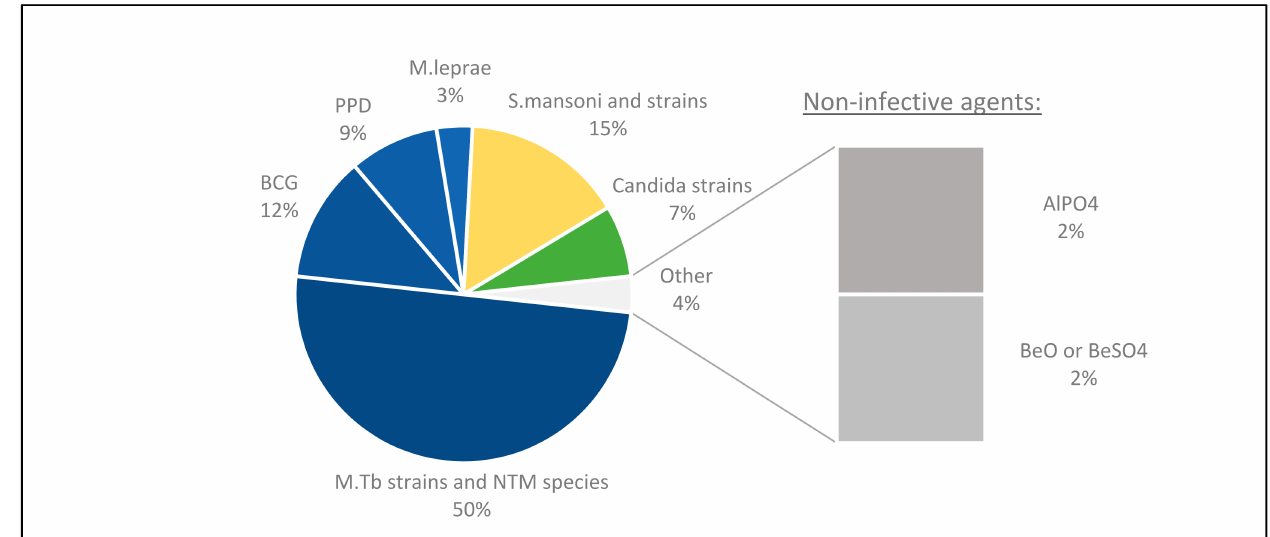
Figure 8. Profiling antigens used in vitro. Most studies focusing on mycobacterial granulomas chose to evaluate different mycobacterial species, and in some studies, BCG and PPD were compared. With other granulomatous diseases, the selection of antigen had specific relevance to either the disease of interest (i.e., Candida ) or the included patient cohort, especially in the case of non-infective agents. Although none of the Schistosomiasis-focused studies prefaced for their preference of conjugating SEA to beads, it was noted that all of these studies implemented the same method, which was first proposed in 1987